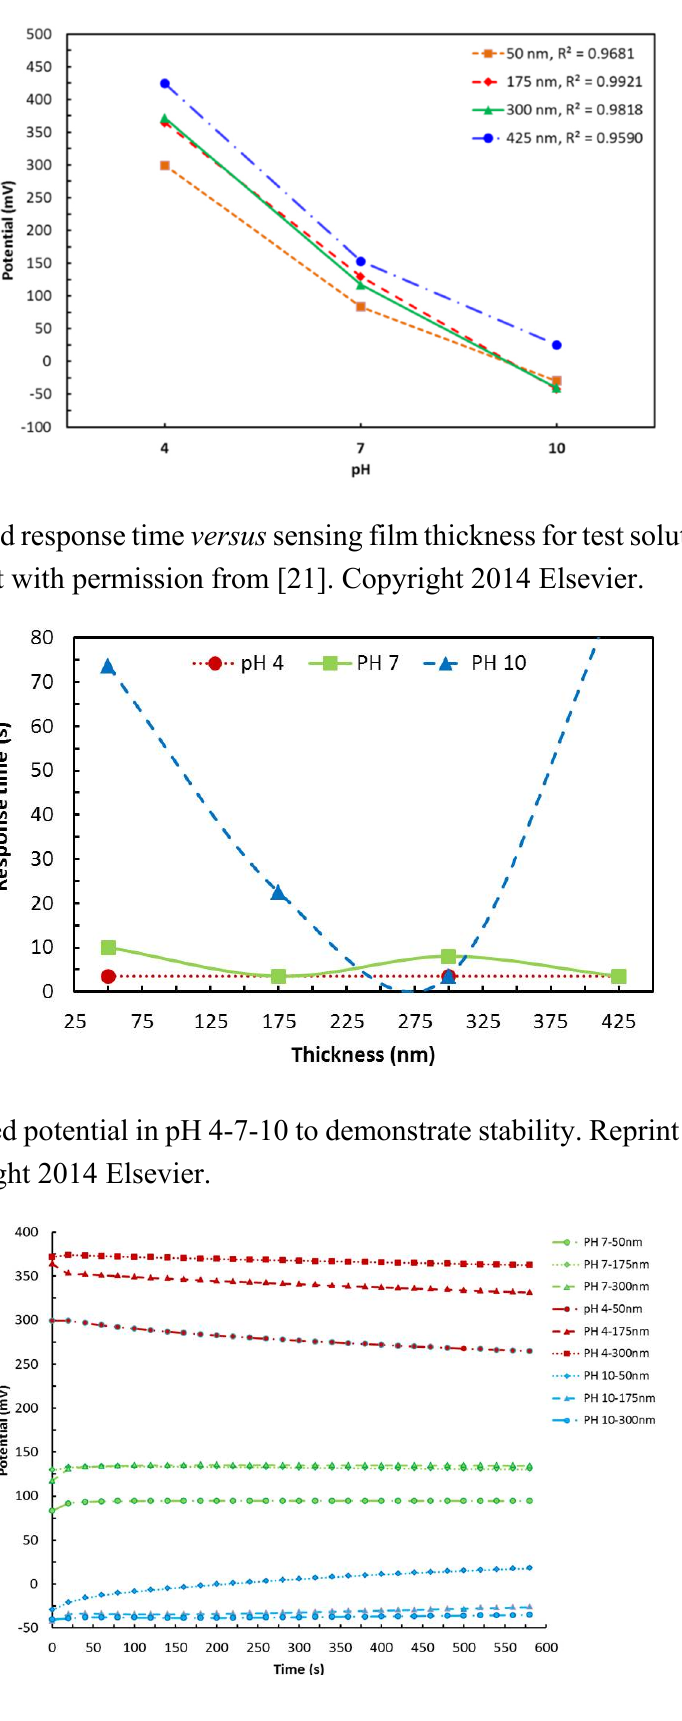
Figure 3. Measured sensor potential versus pH value for different RuO 2 thin-film thicknesses. Reprint with permission from [21]. Copyright 2014 Elsevier.